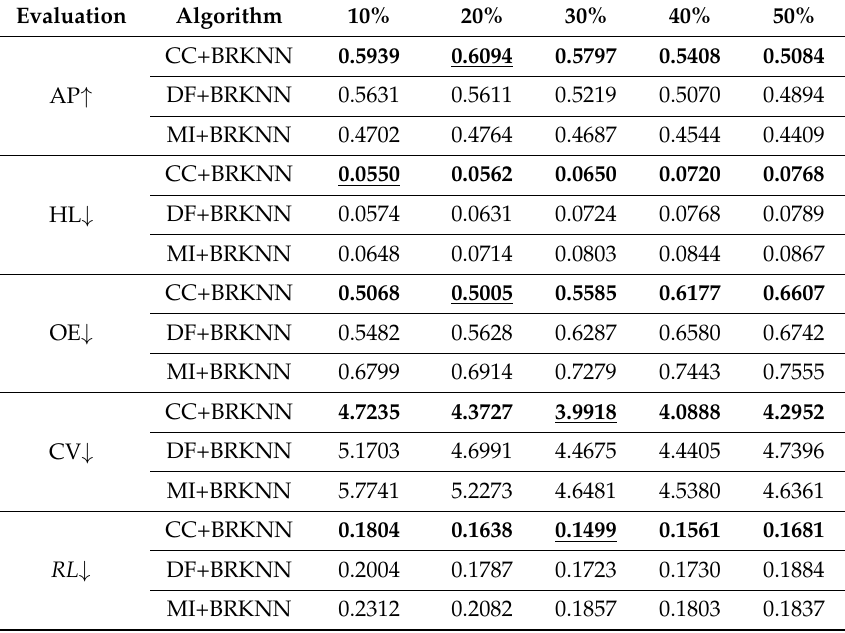
Table 12. Comparison of classification performance on Entertainment data set.